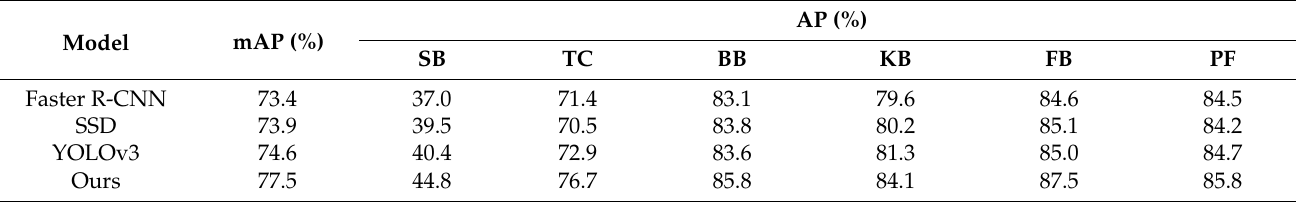
Table 5. The results of this paper’s apple flower detection model are compared with the baseline